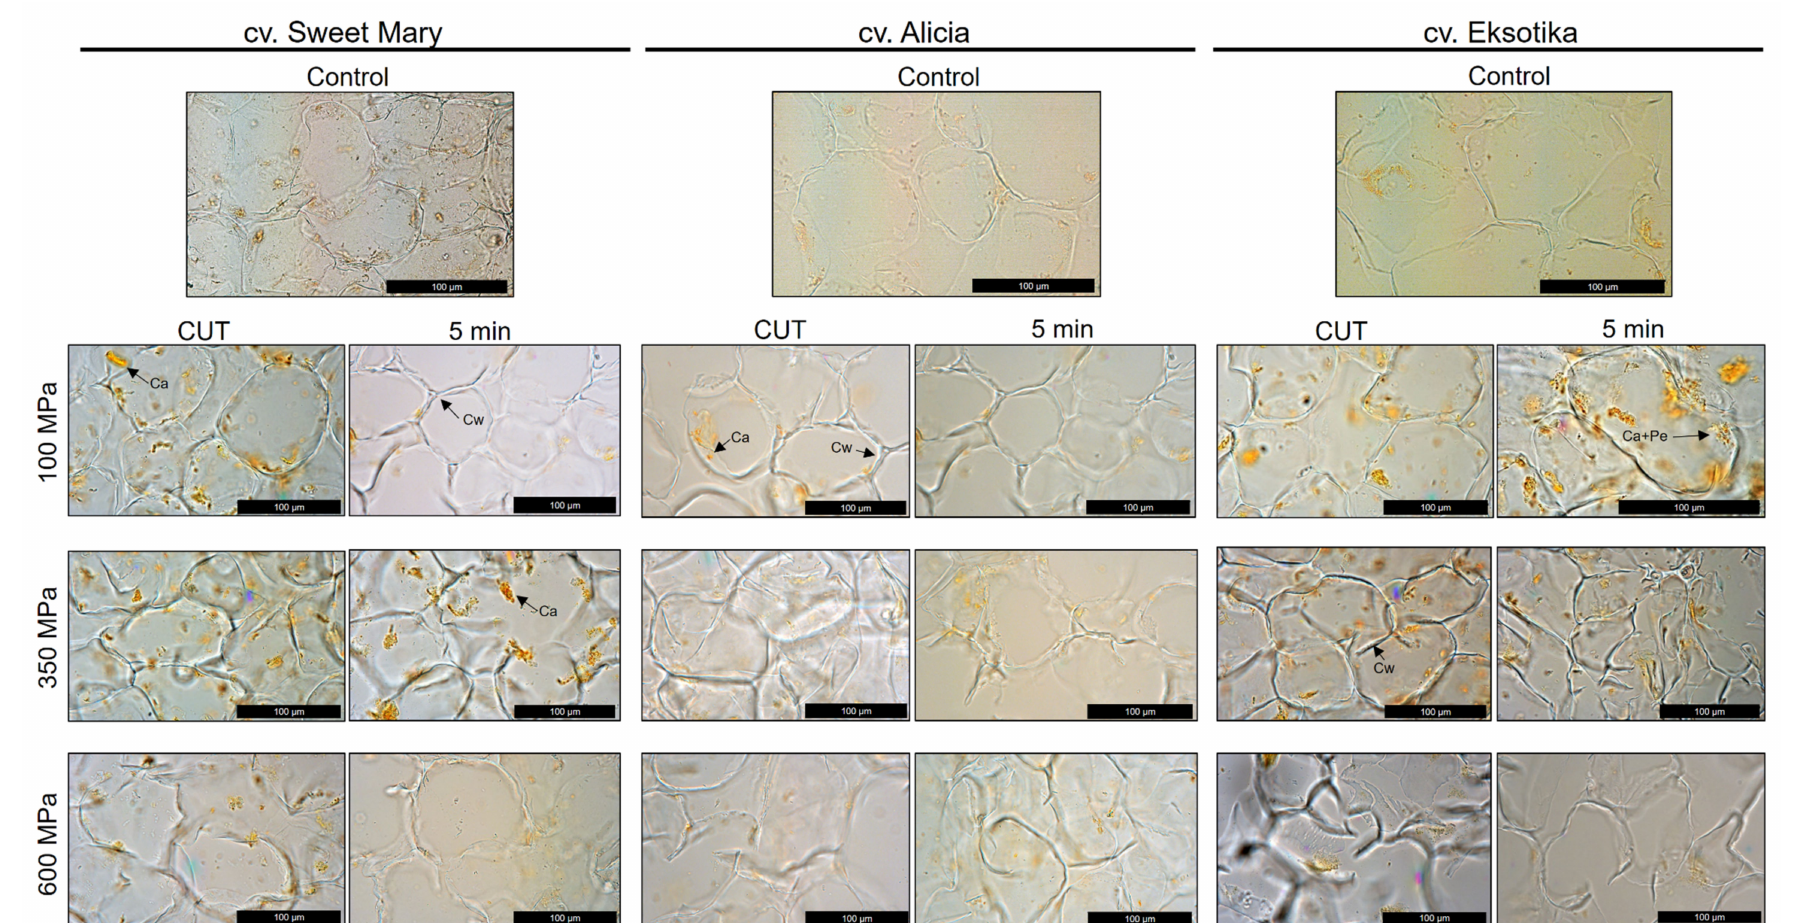
Figure 3. Optical microscopy of Sweet Mary, Alicia and Eksotika papaya ( Carica papaya L.) varieties of untreated pulps and submitted to HHP treatments of 100, 350 and 600 MPa at CUT and 5 min. Ca, carotenoids; Cw, cell wall; Pe+Ca, carotenoids surrounded by